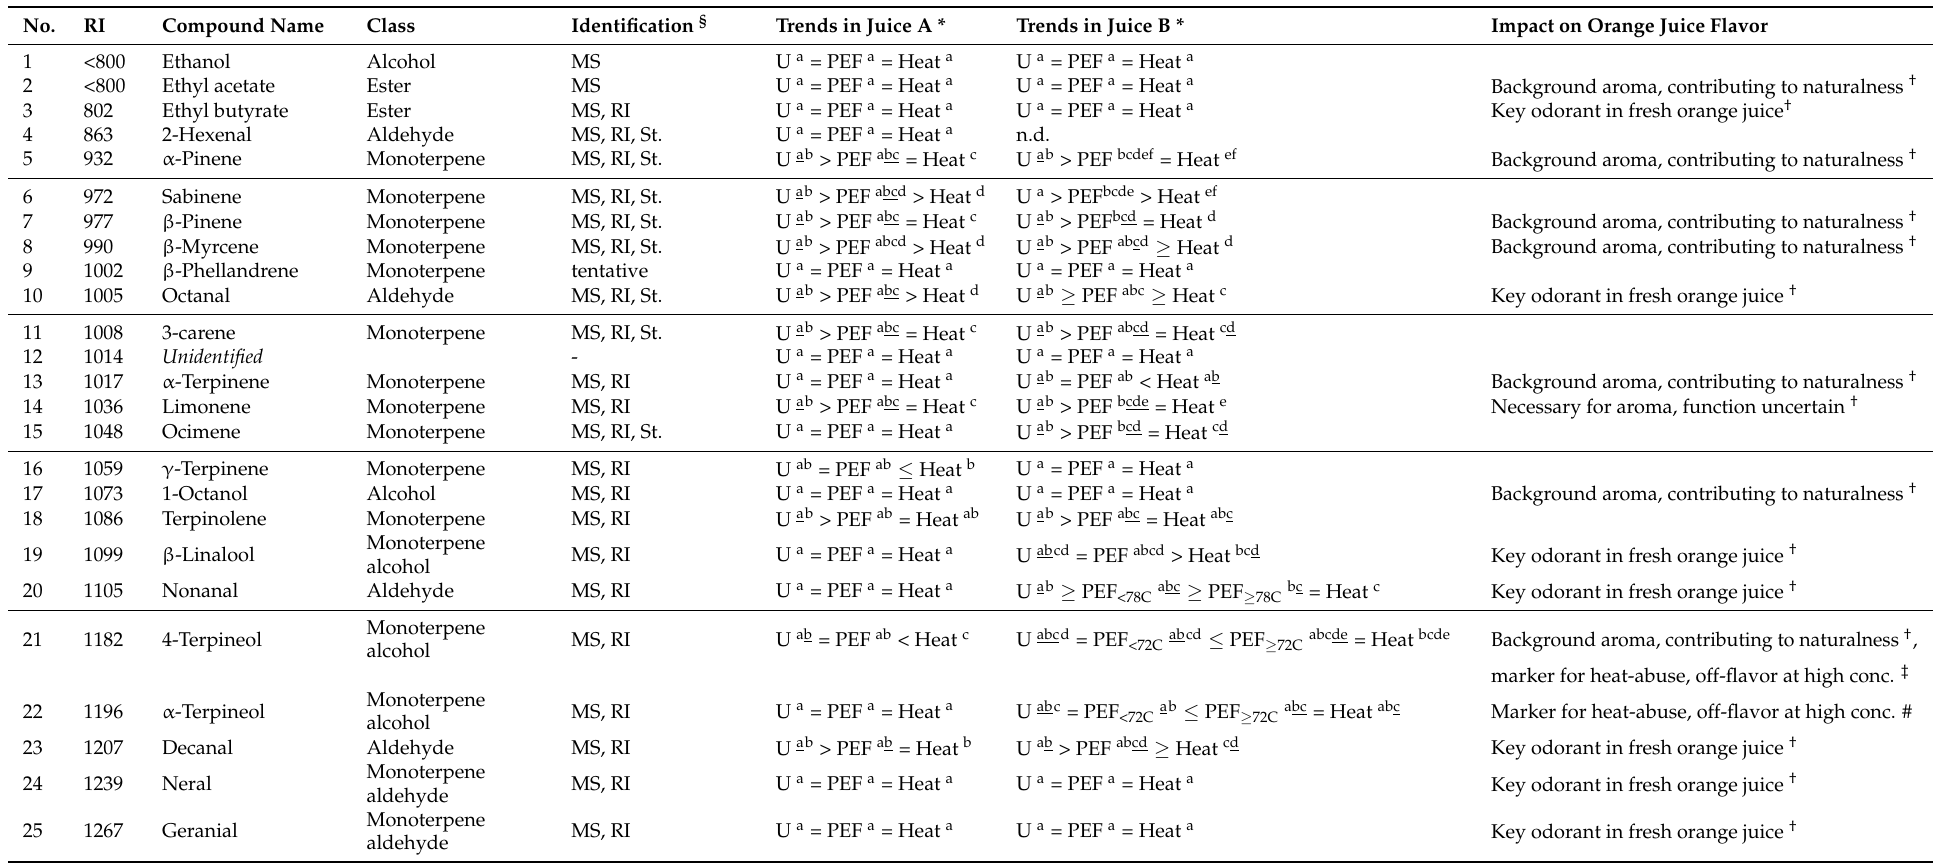
Table 2. Volatile compounds in treated and untreated orange